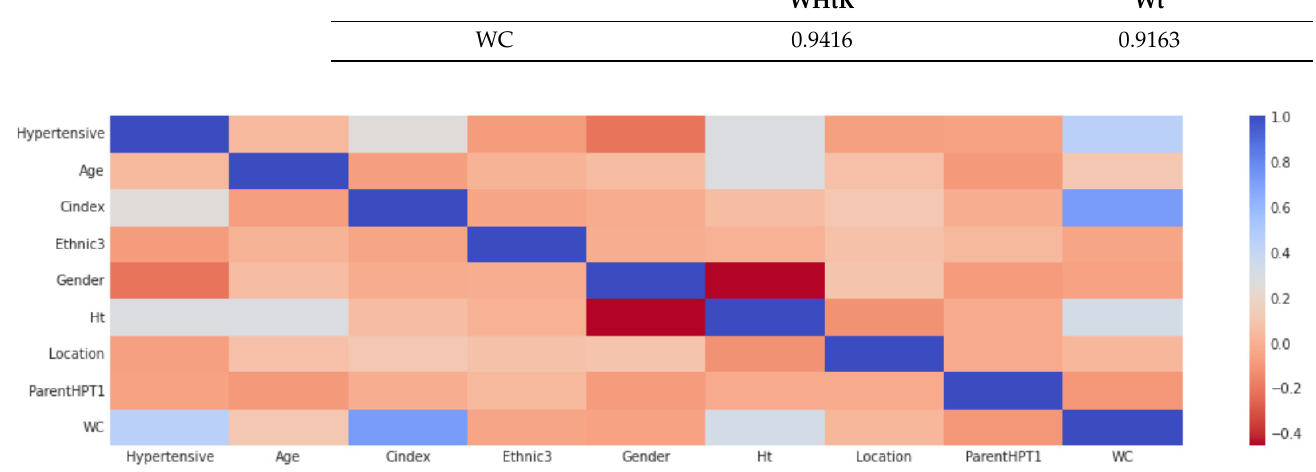
Figure 3. Heatmap showing the correlation coefficient of the 8 selected features: hypertensive, age, C Index (Cindex), ethnicity (Ethnic3), gender, height (Ht), location, parental hypertension (Paren- tHPT1), and waist circumference (WC).